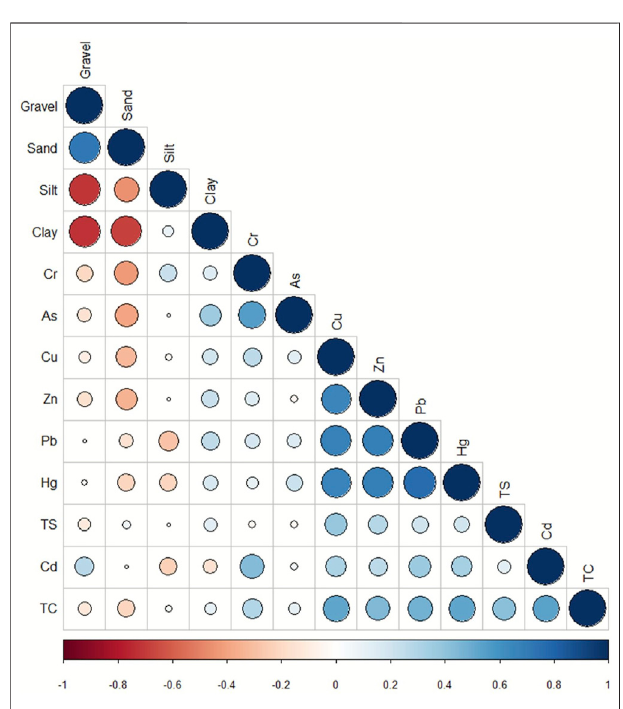
FIGURE 7 | Matrices of Pearson correlation among heavy metals (Cd, Pb,Cr,Cu,Zn,Hg,andAs),gravel,sand,silt,andclaycontents.Redandblue dotscorrespondtonegativeandpositivecorrelations,respectively.Smalldots with light color intensity represent low correlations, while large dots with darker colors correspond to higher correlations. The rows in the correlation matrices refer to parameters in water, and bivalves are included in a rectangular